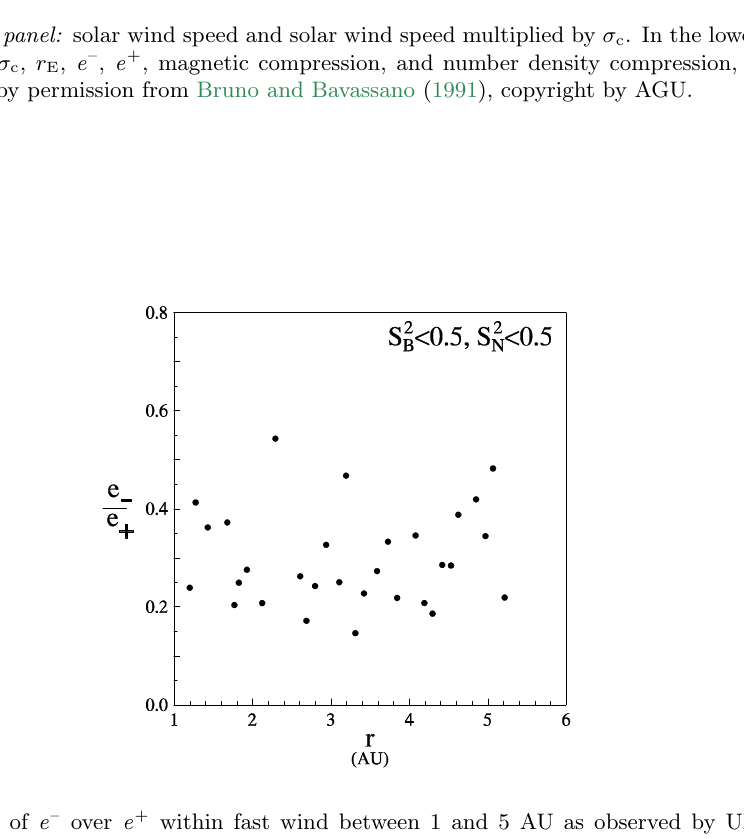
Living Reviews in Solar Physics